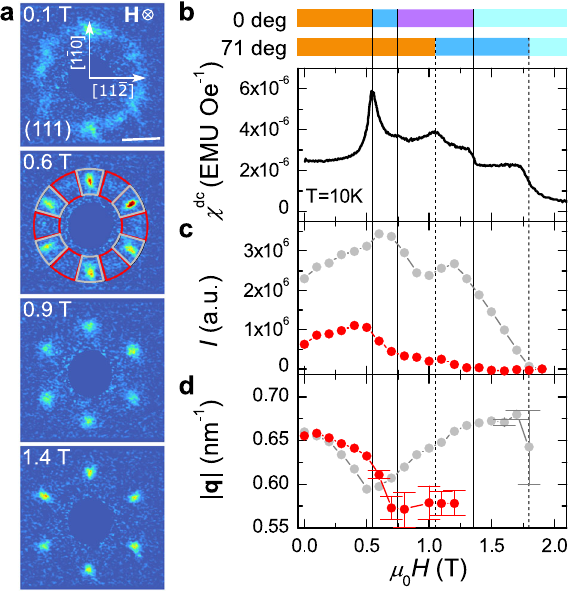
Fig. 4 Magnetic fi eld dependence of the spin texture at 10 K. SANS images acquired at 10 K in increasing magnetic fi elds are shown in panel a . The scale bar represents 0.5 nm − 1 . Both the neutron beam and the direction of the magnetic fi eld was parallel to the [111] direction. The magnetic fi eld dependence of the susceptibility shown in panel b is compared with the scattering intensity (panel c ) and the position of the intensity peak (panel d ) measured in the grey and red sections of the SANS patterns. The coloured stripes (same colour coding as in Fig. 3) at the top of panel ( b ) represent the sequence of phase transitions in P 1 and P 2 − 4 domains with polar axes spanning 0 ∘ and ~71 ∘ with respect to the fi